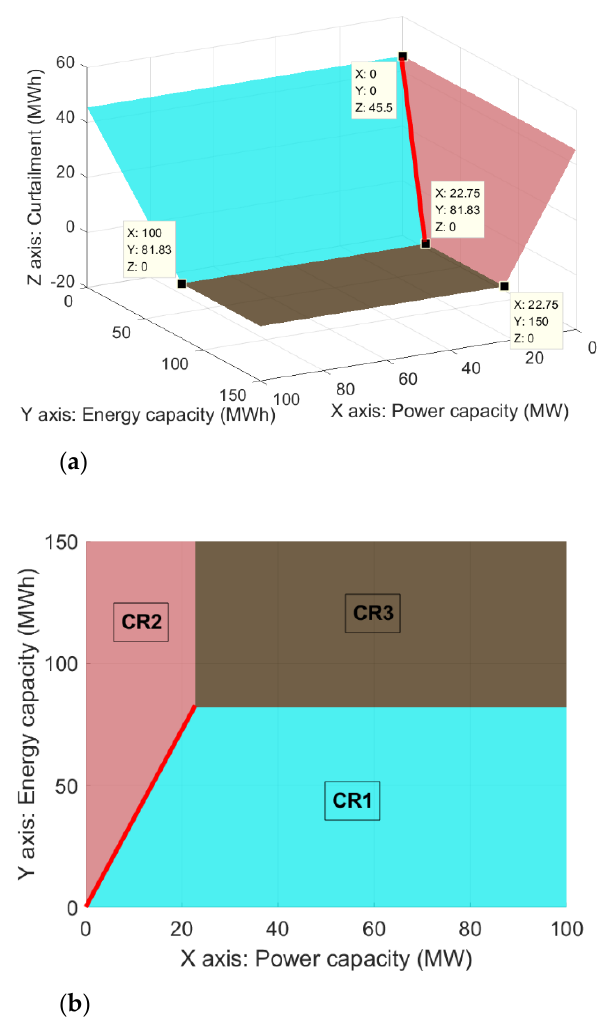
Figure 4. Results in Scenario 3 of wind power ( a ) optimal value function and ( b ) critical regions. It can be seen that, without an ESU, the total renewable energy curtailment under Scenario 3 reaches 45.5 MWh. By employing an ESU whose power/energy capacity is higher than 22.75 MW/81.83 MWh, respectively, the curtailment reduces to zero. The parameter set is divided into three critical regions, named CR1, CR2, and CR3.